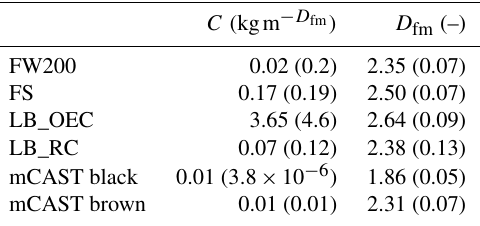
Table A4. Mass–mobility prefactor, C , and fractal dimension, D fm , derived from power–law fits of the form of Eq. (A4) to mass– mobility data shown in Fig. 4a. A D fm value of 1 corresponds to a straight chain-like structure, whereas D fm = 3 indicates a compact sphere-like structure. The value in brackets indicates the standard